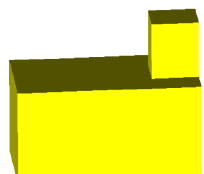
Figure 3. Schematic diagram of block body model.